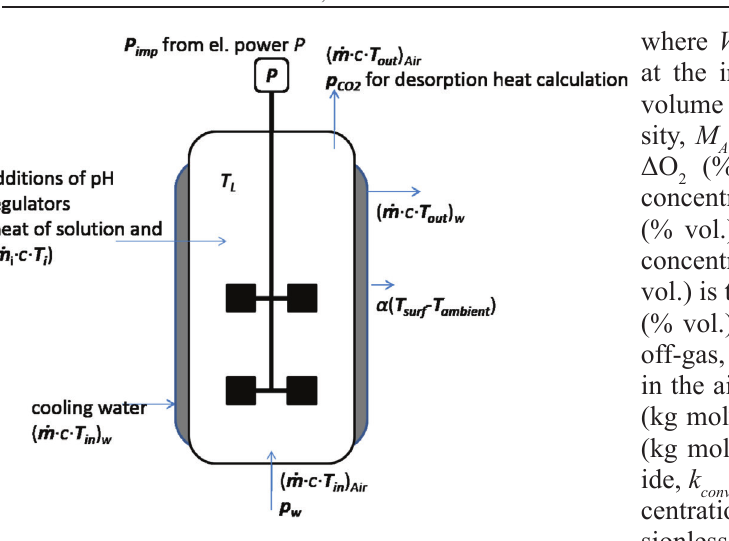
Fig. 1 – Bioreactor scheme with the process variables (in Italics and Bold) which are needed to be measured in